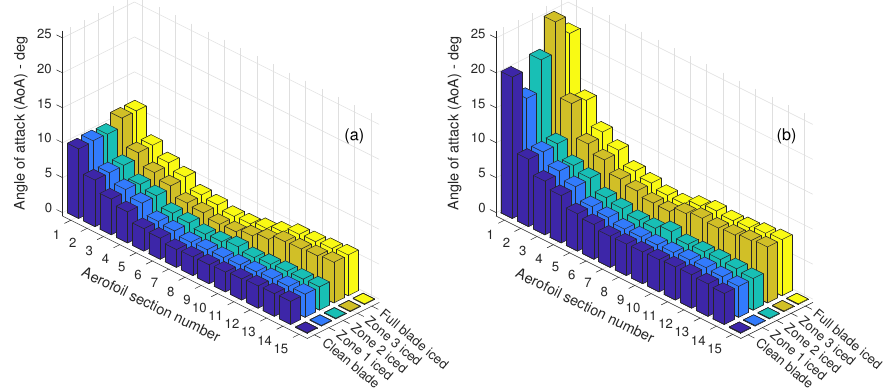
Figure 16. Comparison of angles of attack on aerofoil sections of the clean and iced blades at wind speeds ( a ) 6 m/s, ( b ) 10 m/s.